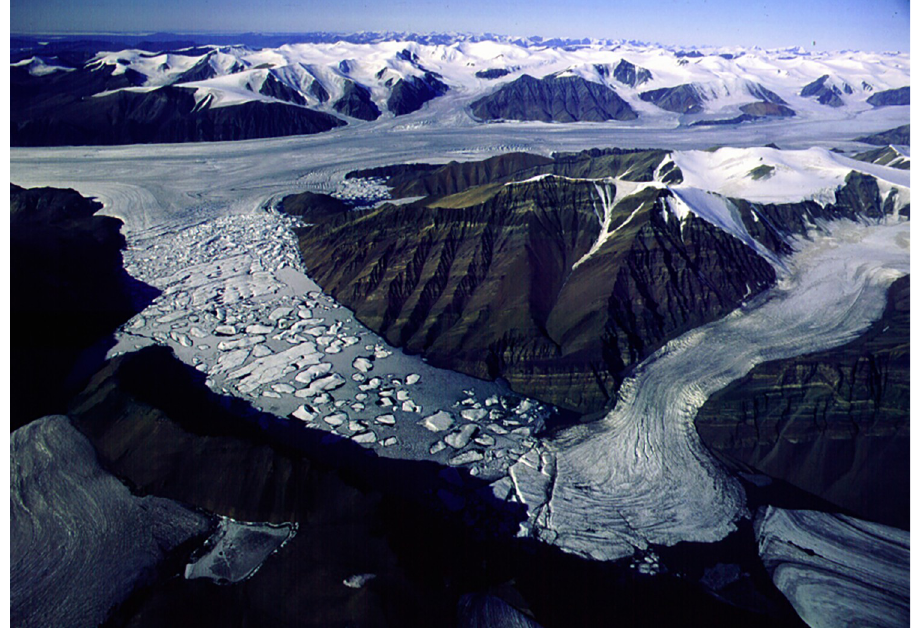
Fig 4. Aerial image of Phantom Lake looking toward the Thompson Glacier, May 2003. The lake is 4 km long.